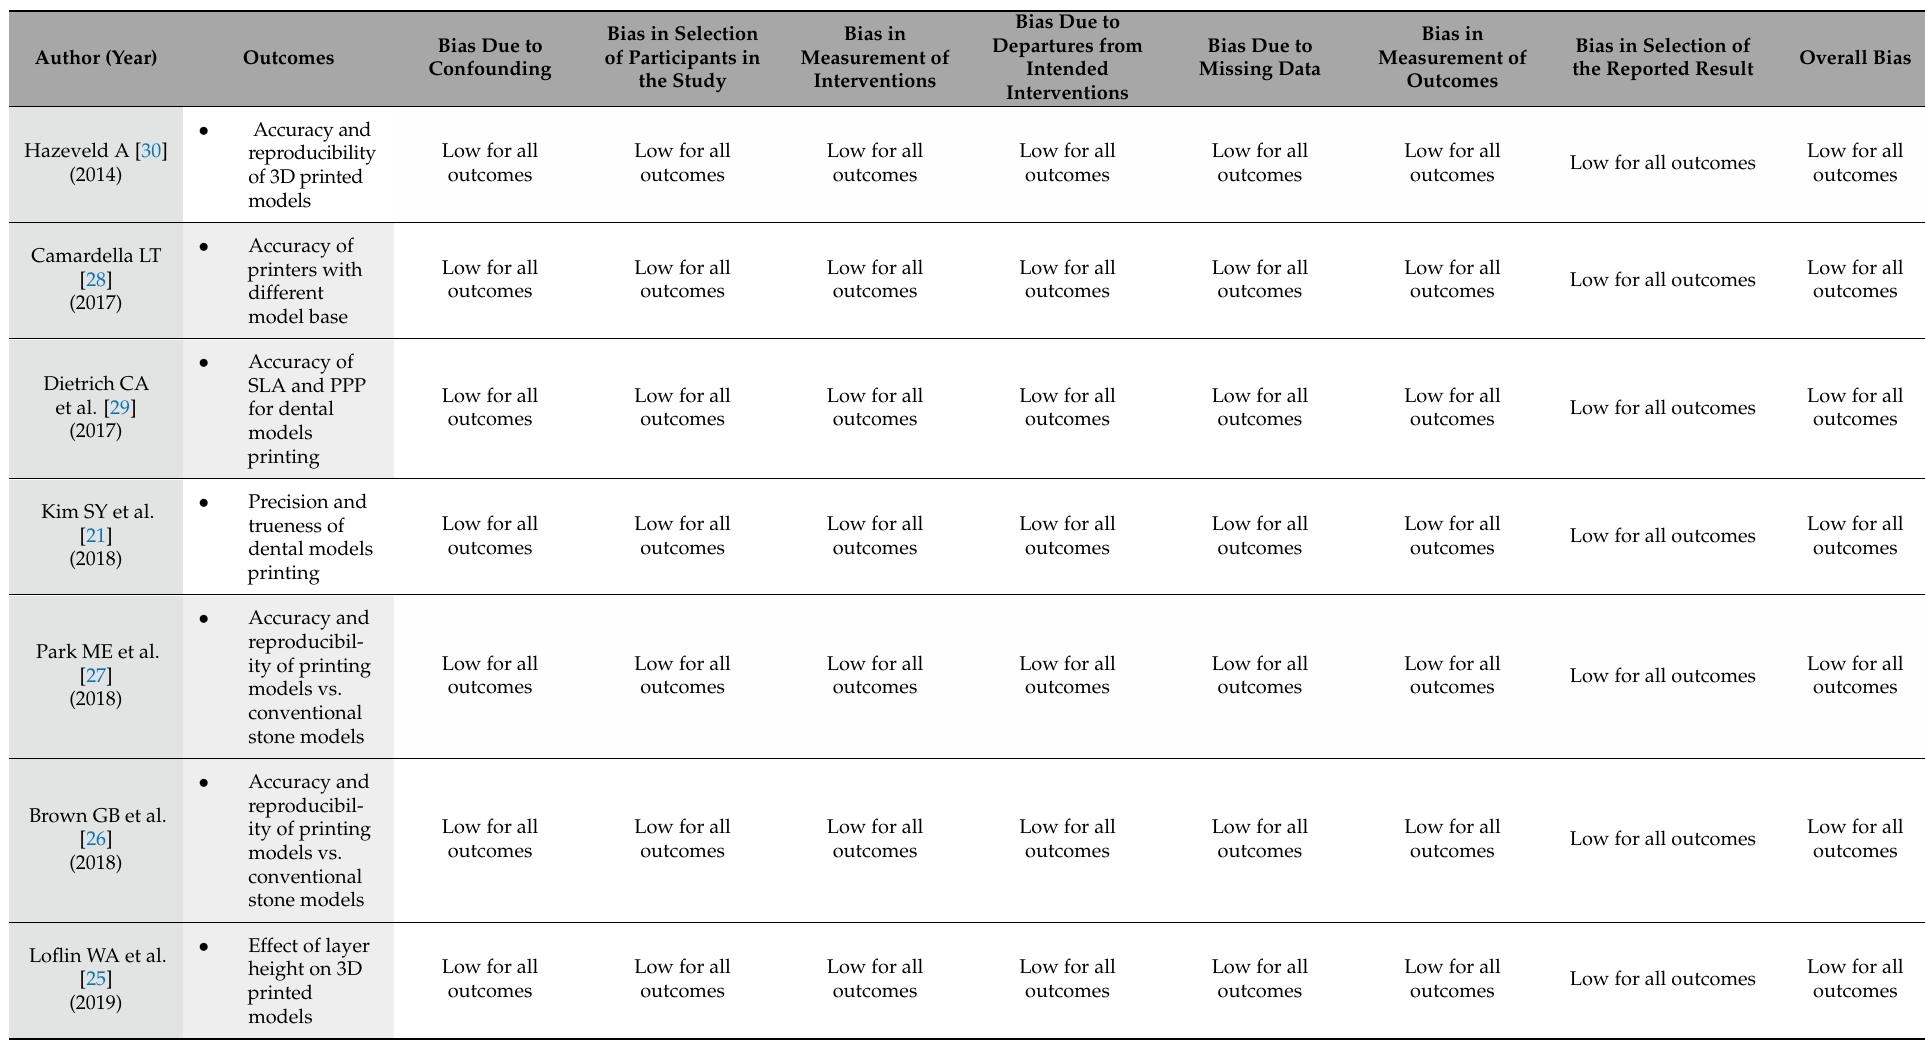
Table 4. Risk of bias